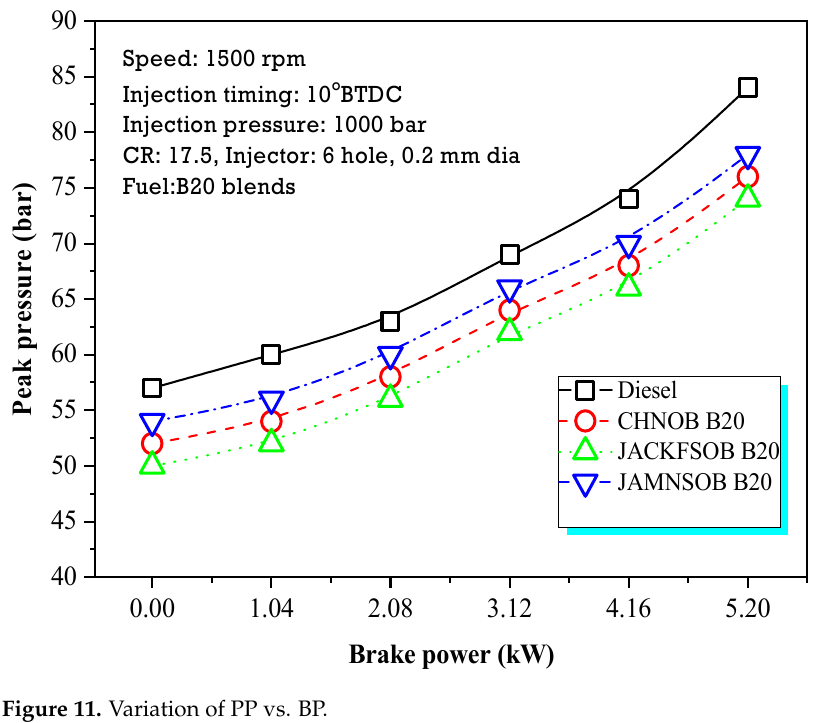
Figure 11. Variation of PP vs. BP.